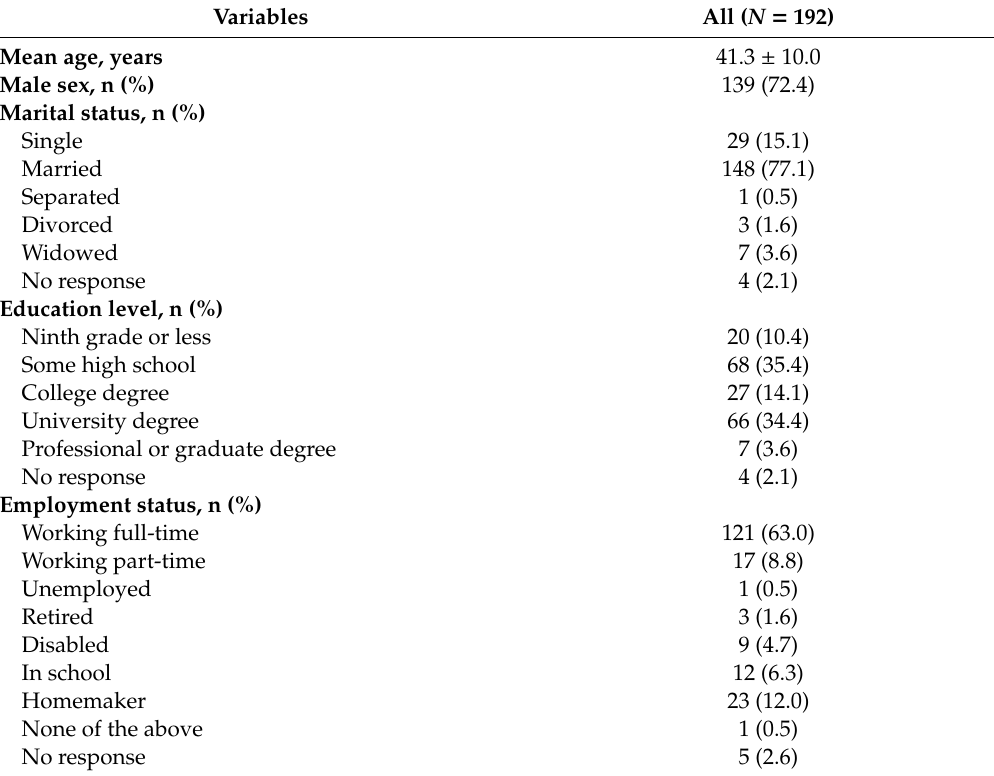
Table 1. Main baseline characteristics of the 192 patients who responded to the questionnaire.